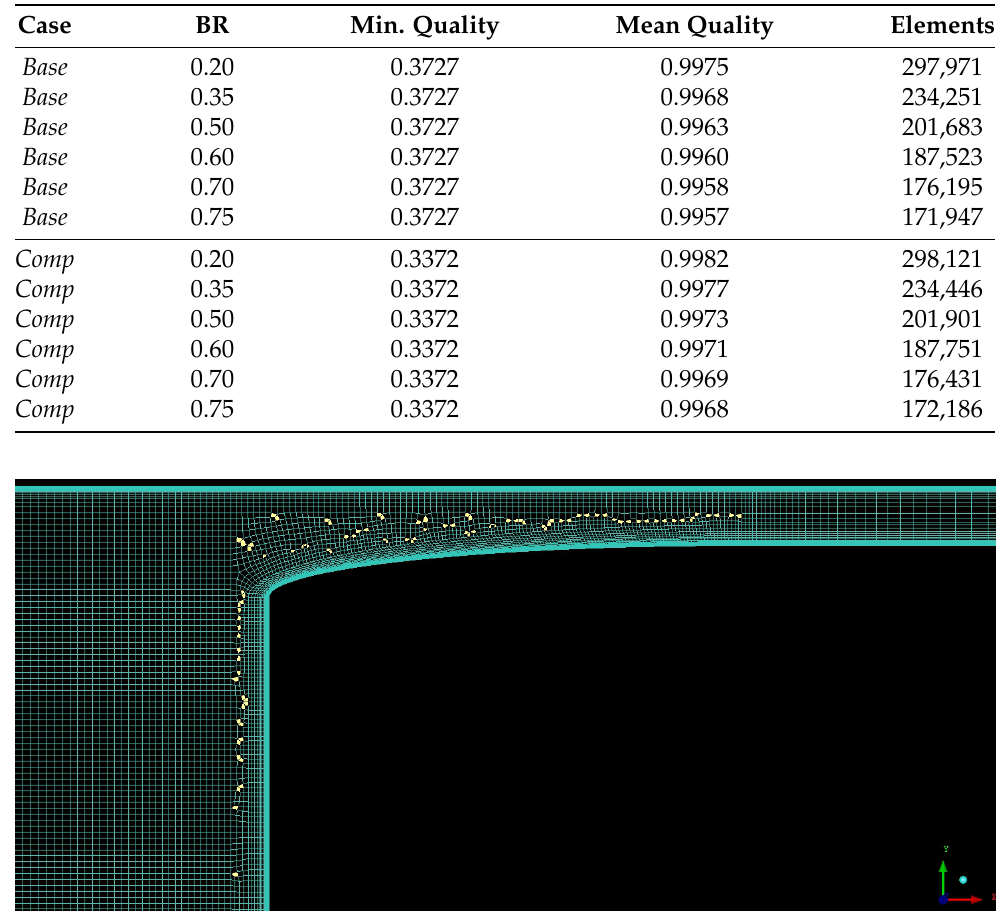
Table 1. Quality and mesh size for the different cases.